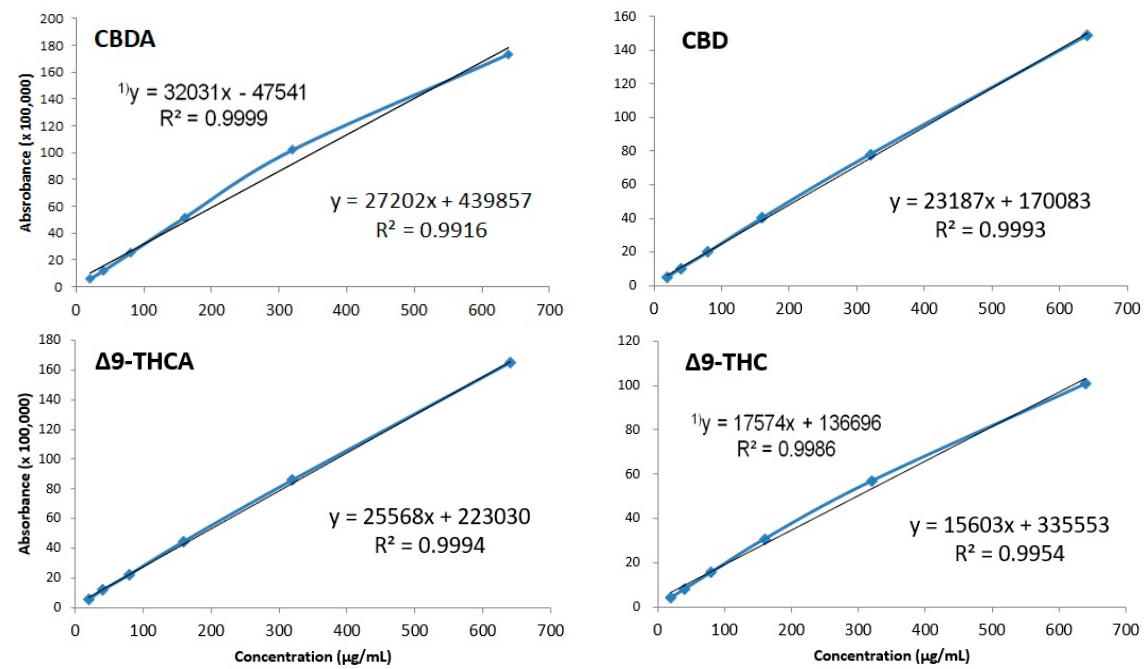
Figure 5. Calibration curves of four cannabinoids shown through the method of least squares. Regression equation and correlation coefficient with 640 µ g/mL deleted. CBDA and ∆ 9-THC at 640 µ g/mL were excluded from the quantification due to the violation of the Beer–Lambert